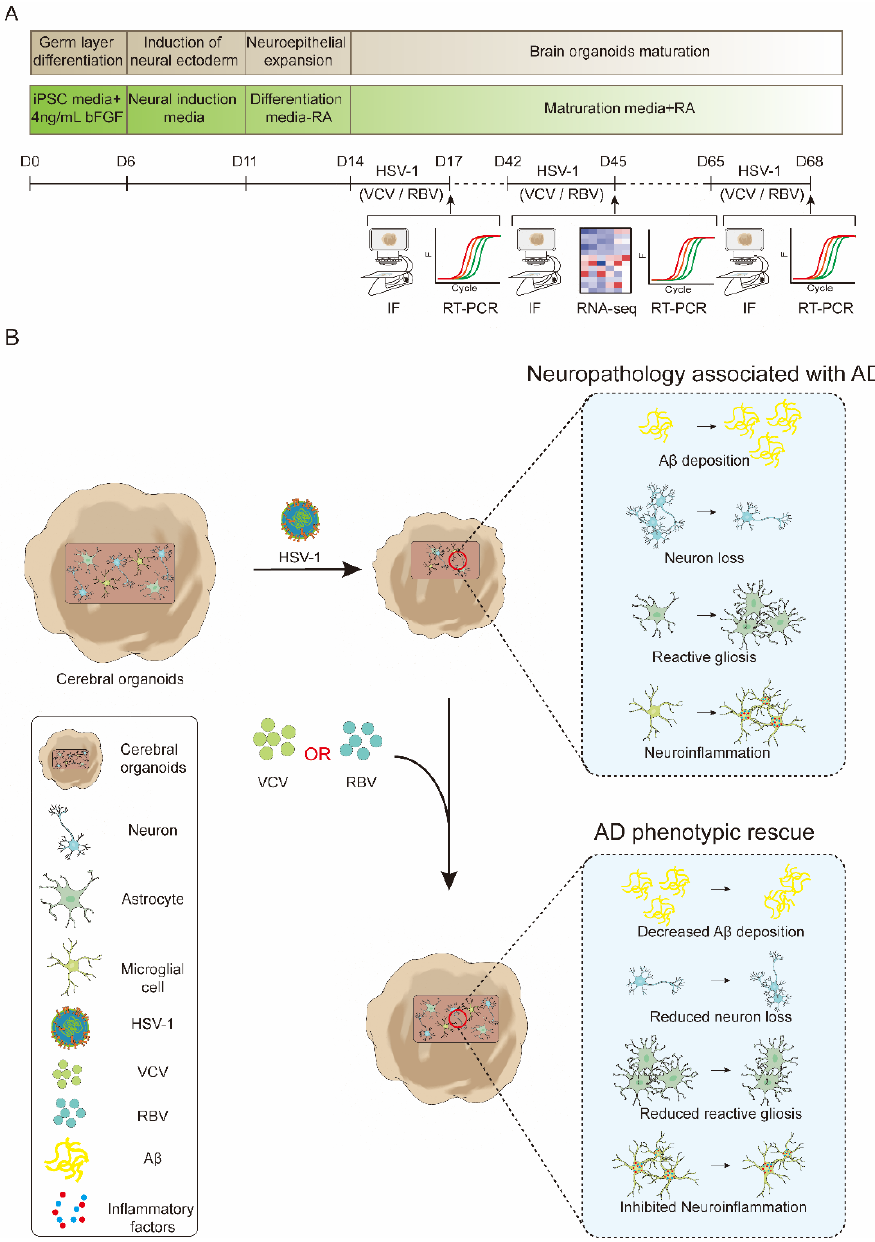
Figure 1. Schematic diagram of cerebral organoids for modeling of HSV-1-induced-A β associated neuropathology and phenotypic rescue. ( A ) Schematic procedure of HSV-1-infected cerebral organoids timing and method. ( B ) Cerebral organoids for modeling of HSV-1-induced-multiscale neuropathology associated with Alzheimer’s disease and phenotypic rescue. HSV-1-infected cerebral organoids could model typical neuropathological features associated with AD including multicellular A β deposition, neuron loss, reactive gliosis, and neuroinflammation. Furthermore, both RBV and VCV significantly rescued the HSV-1-induced pathological phenotypes associated with AD.